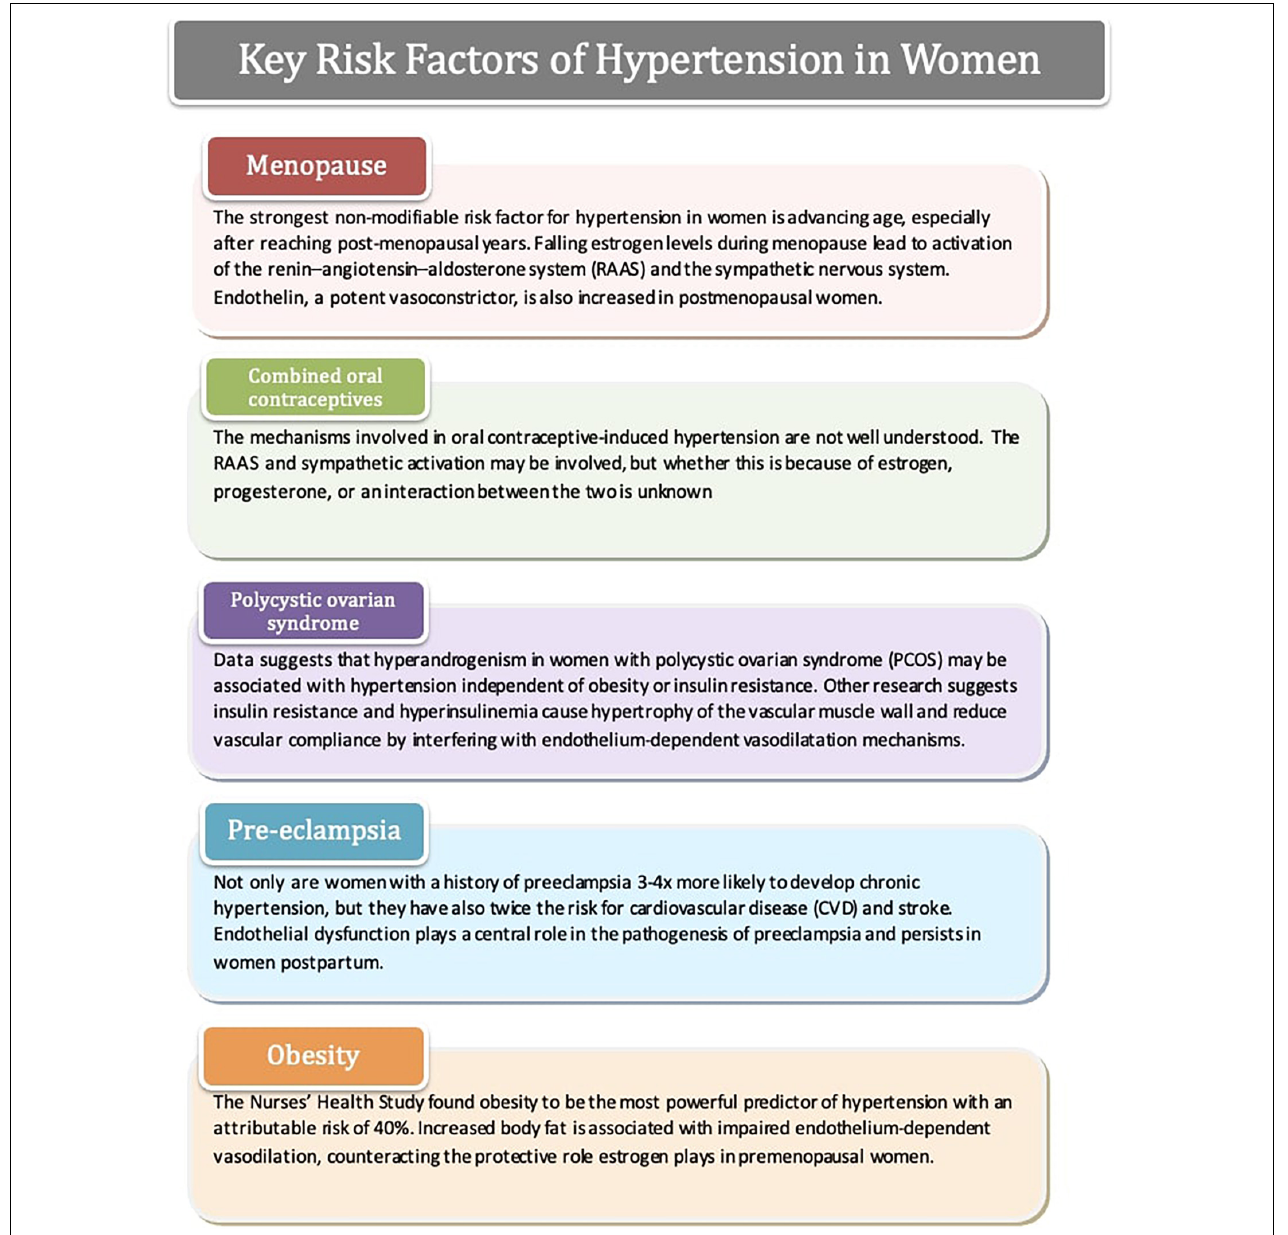
FIGURE 1 | Key risk factors of hypertension in